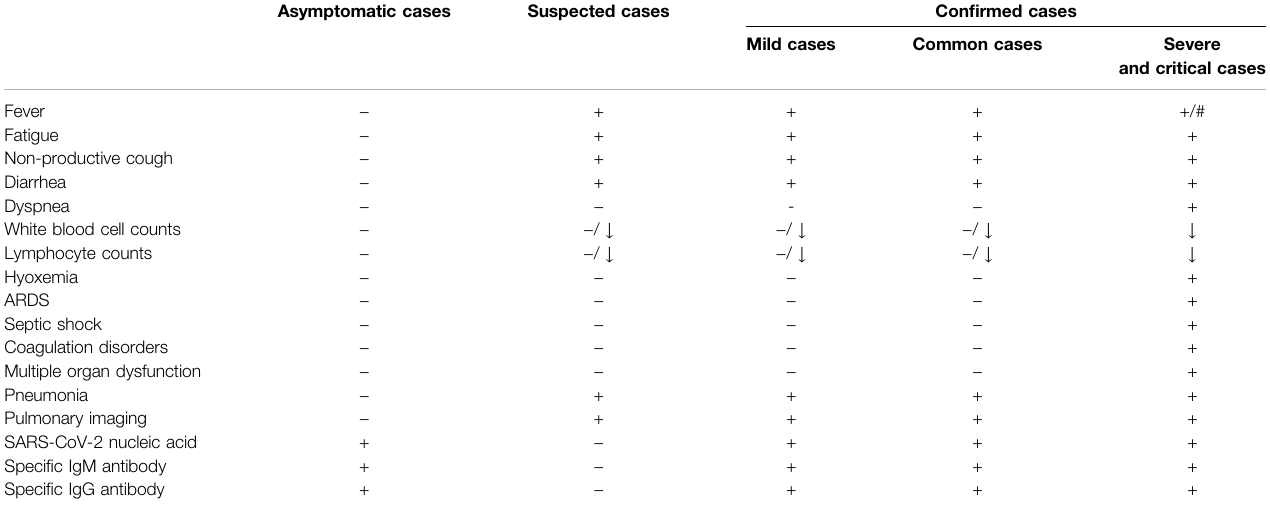
TABLE 1 | Clinical features of COVID-19.